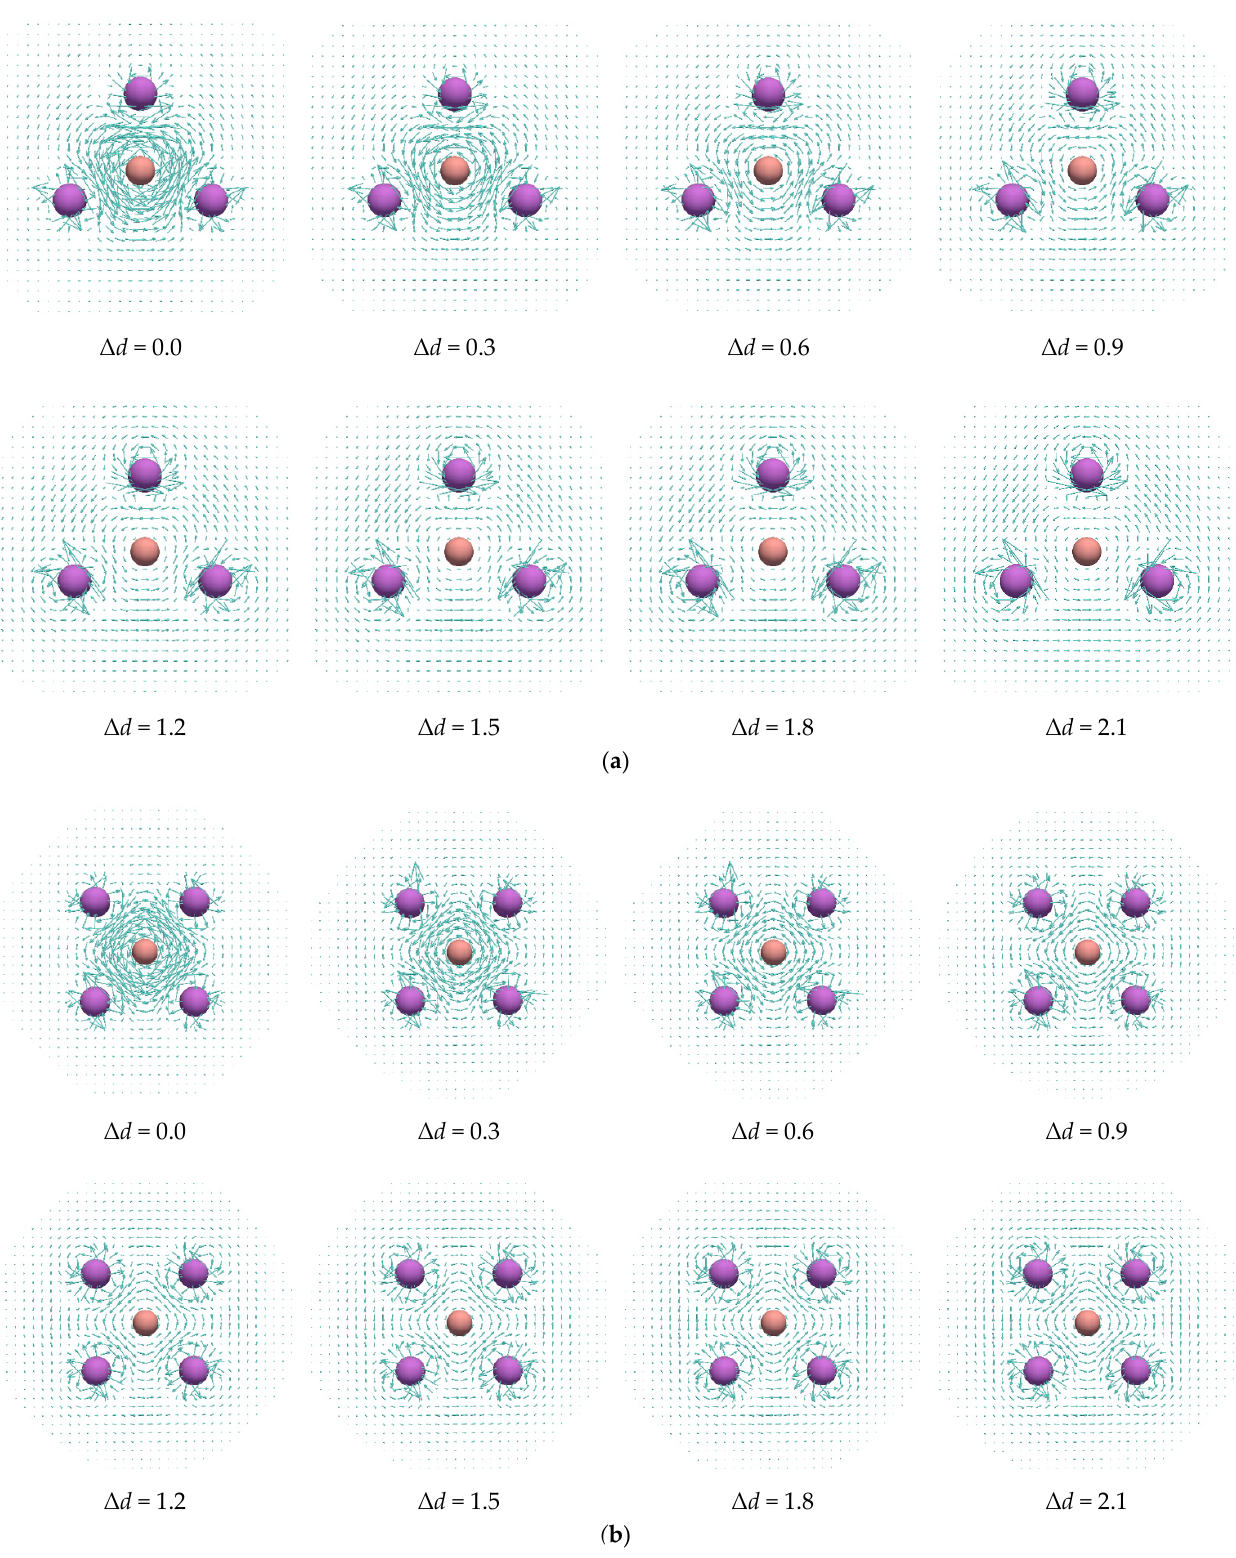
Figure 5. Current density maps of the structures in which, starting from the optimized geometries of Li 3 B 2 − ( a ) and Li 4 B 2 ( b ), the B–B distances were elongated by Δ d (in Å), while the Li-atom positions were kept unchanged. Table 3. Natural atomic charges of B atoms, NICS(0) , and MCI 1/n values of the structures in ZZ which the B–B distances were simultaneously elongated by Δ d value, while the Li-nuclei positions were kept unchanged.